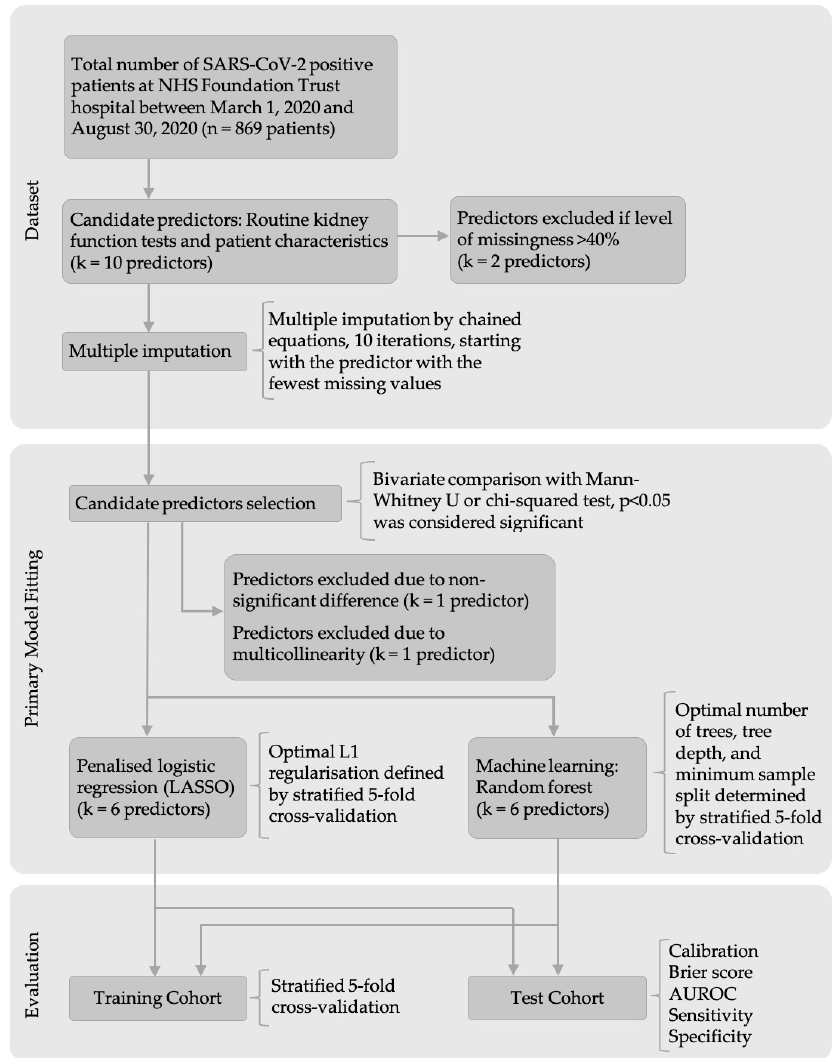
Figure 3. Model development and evaluation workflow. Table 1. Demographics and kidney function characteristics.